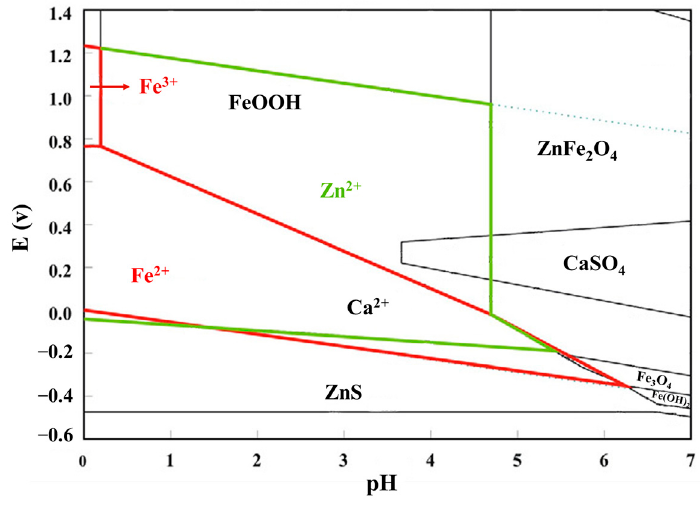
Figure 5. E–pH diagrams for the Zn–Ca–Fe–S–H 2 O system at 20 °C [27].